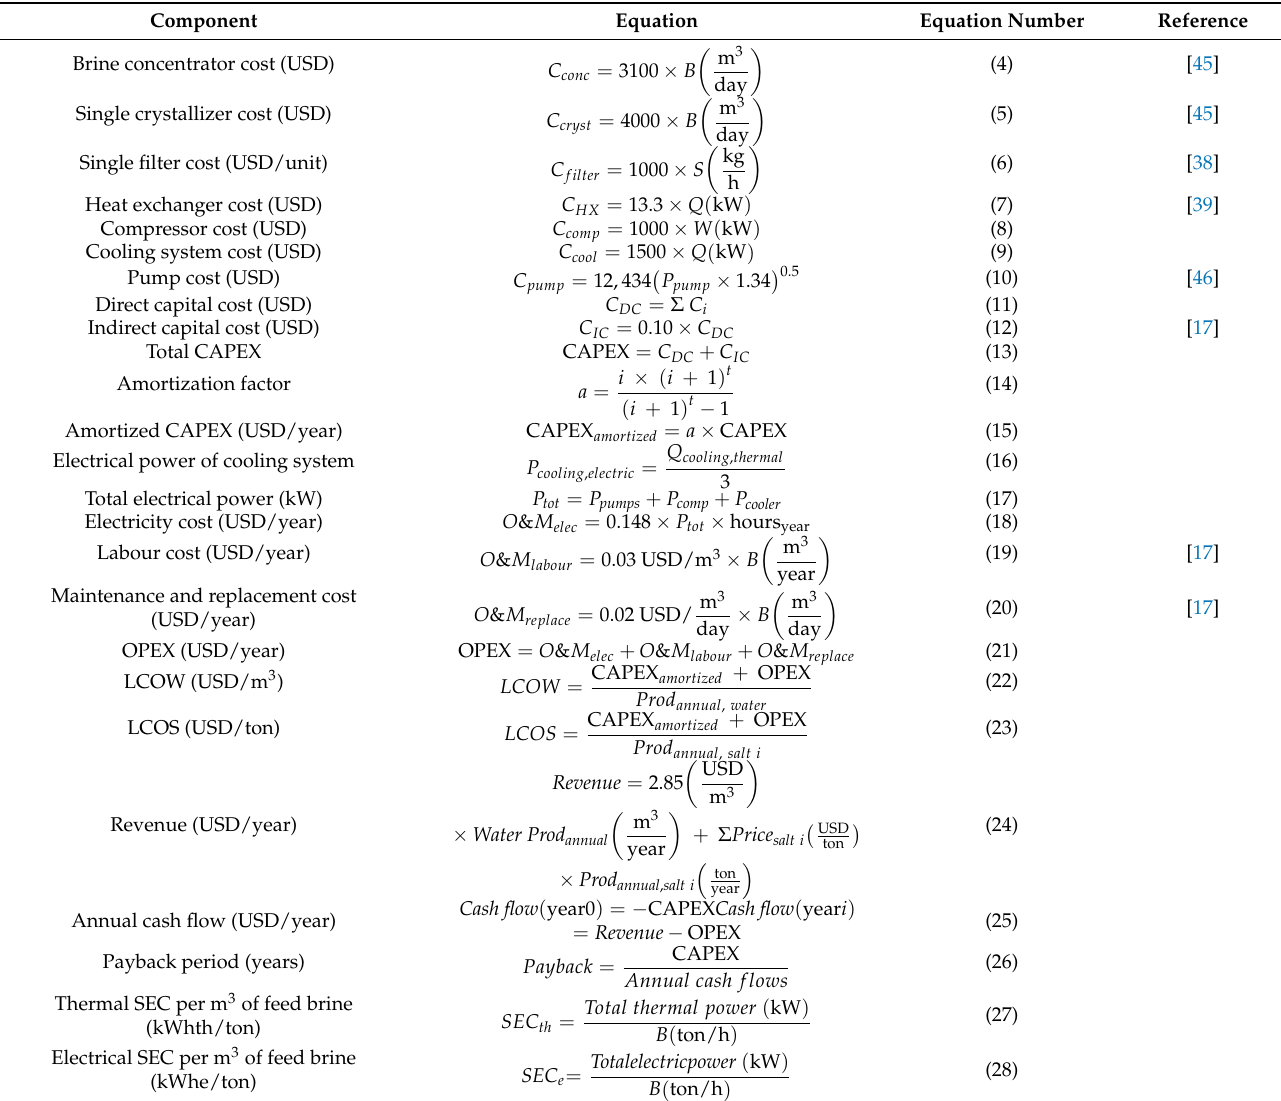
Table 5. Economic analysis equations.